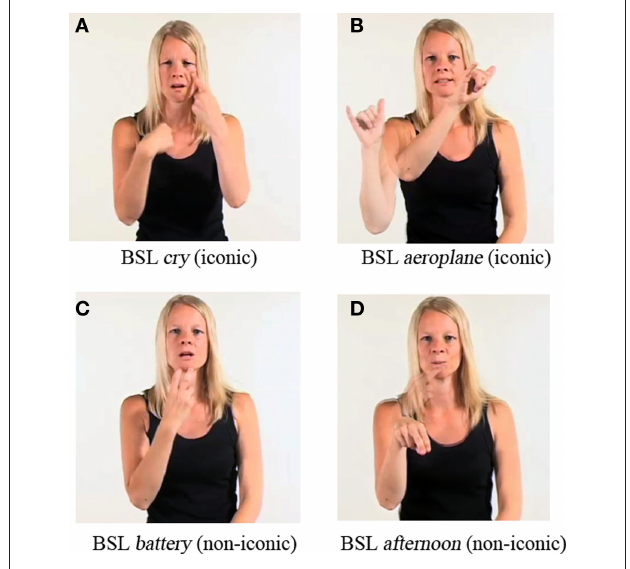
FigurE 1 | Examples of iconic signs meaning cry (a) and aeroplane (B) and non-iconic signs meaning battery (c) and afternoon (d) in